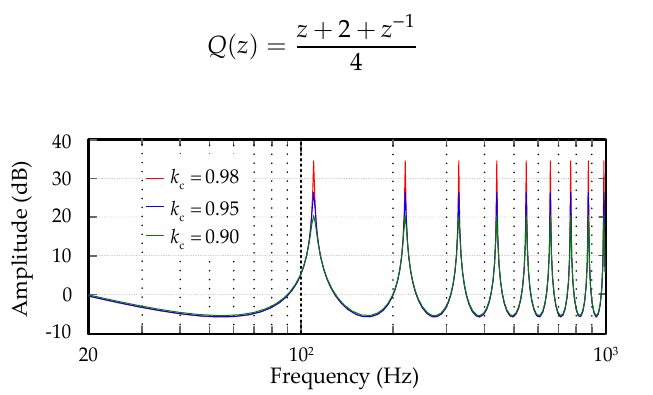
Figure 8. When Q ( z ) = 1, the amplitude-frequency characteristic curves of RC under di ff erent k c . Figure 8. When   1 Q z  , the amplitude-frequency characteristic curves of RC under different Due to the symmetry of   Q z , its output has no phase shift relative to the input. When